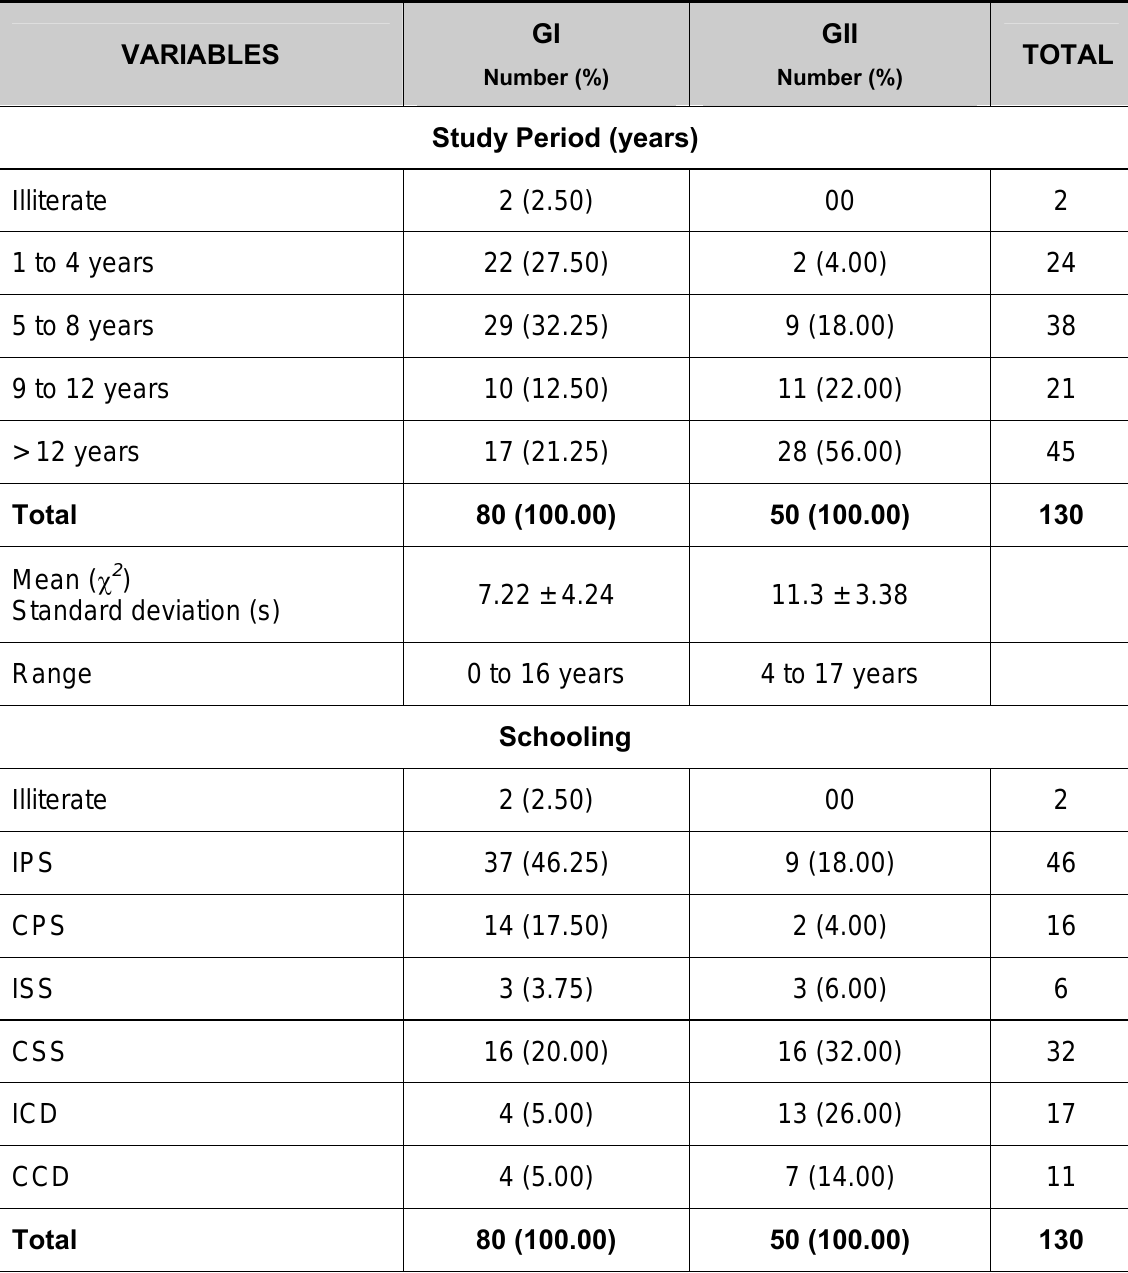
Table 1. Distribution of quantitative variables of the eighty individuals infected by virus C (GI) and fifty non-infected persons (GII), according to sociodemographic characteristics. Mean ( χ 2 ) and standard deviation (s). Calculated statistics: t , p and z